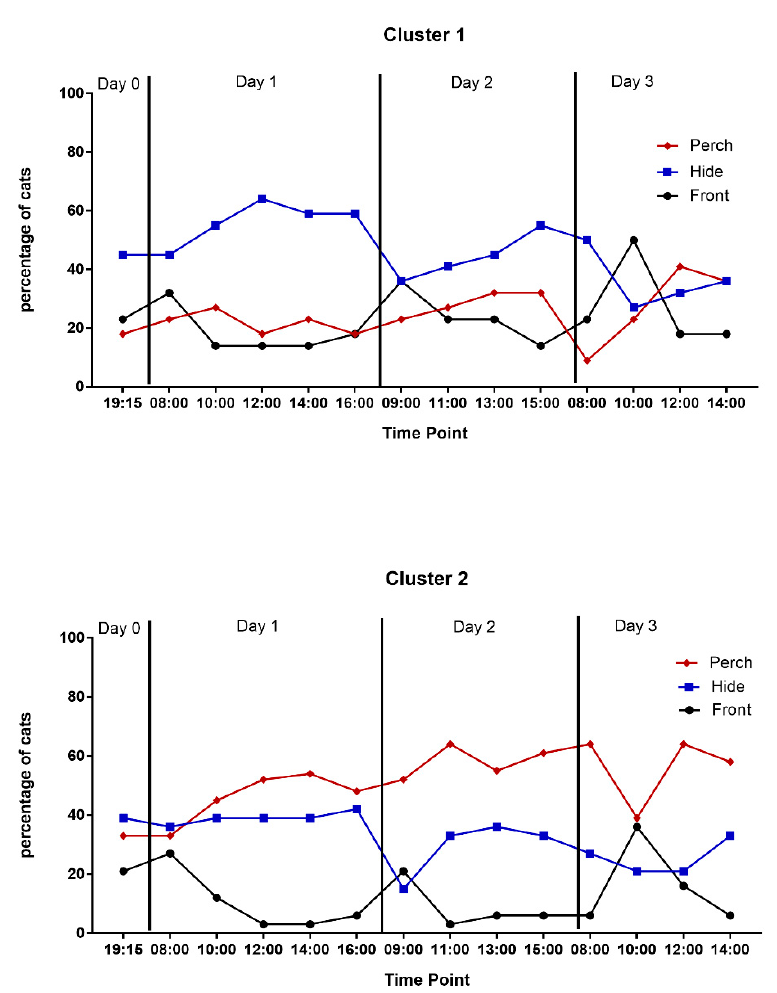
Figure 3. Percentage of cats in the front half, hide box, or perch by cluster during scan sampling.